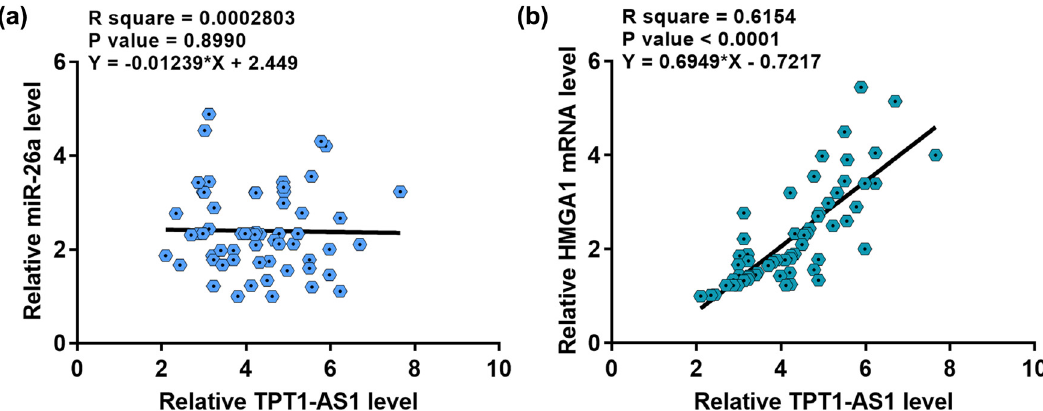
Figure 3: TPT1 - AS1 was positively correlated with HMGA1 mRNA. ( a ) The correlation between TPT1 - AS1 and miR - 26a across ESCC tissues. ( b ) The correlation between TPT1 - AS1 and HMGA1 mRNA across ESCC